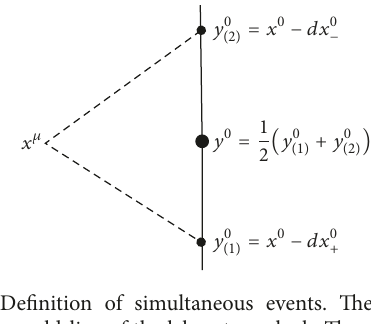
Figure 1: Definition of simultaneous events. The vertical line represents a world-line of the laboratory clock. The points 𝑦 0 (1) and 𝑦 0 𝑥 휇 . Then the middle point 𝑦 0 represents (2) have null-interval with the event simultaneous with 𝑥 휇